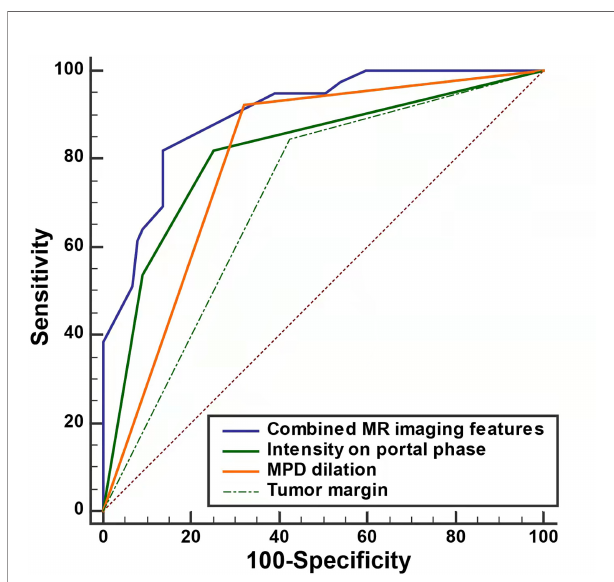
FIGURE 5 | The decision curve analysis for the MRI-based nomogram. The red line displays the integrated MRI features, the blue line the signal in the portal phase, the purple line the MPD dilation, the green line the tumor margin, the gray line the hypothesis that all patients had non-hypervascular PNETs, and the black line the hypothesis that all patients had PDACs. The x - axis displays the high-risk threshold and the y -axis represents the net bene fi